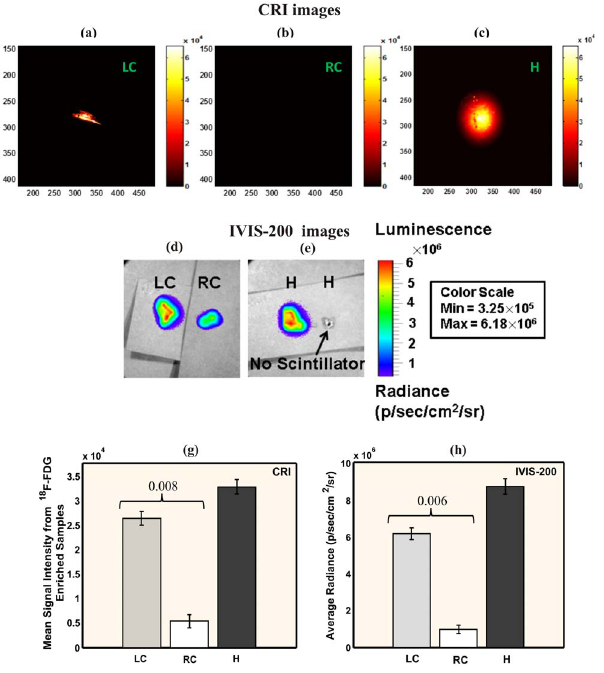
Figure 3. Radioluminescence imaging of exvivo murine carotid arteries. Radioluminescence imaging was taken one hour after 18 F- FDG intravenuous injection (0.964 mCi) with the CRI system: (a–c) and with the IVIS-200 system: (d–e). (a) LC: ligated left carotid artery, (b) RC: non-ligated right carotid artery artery (negative control), (c) H: heart (positive control). (d) both LC and RC artery under scintillator, (e) left: heart under scintillator, right: heart without scintillator; (g) average signal intensity of tissue samples from the CRI system images (h) average radiance of the samples from the IVIS-200 system images. High radioluminescence signal from LCs was detected by the CRI system and confirmed by IVIS-200.